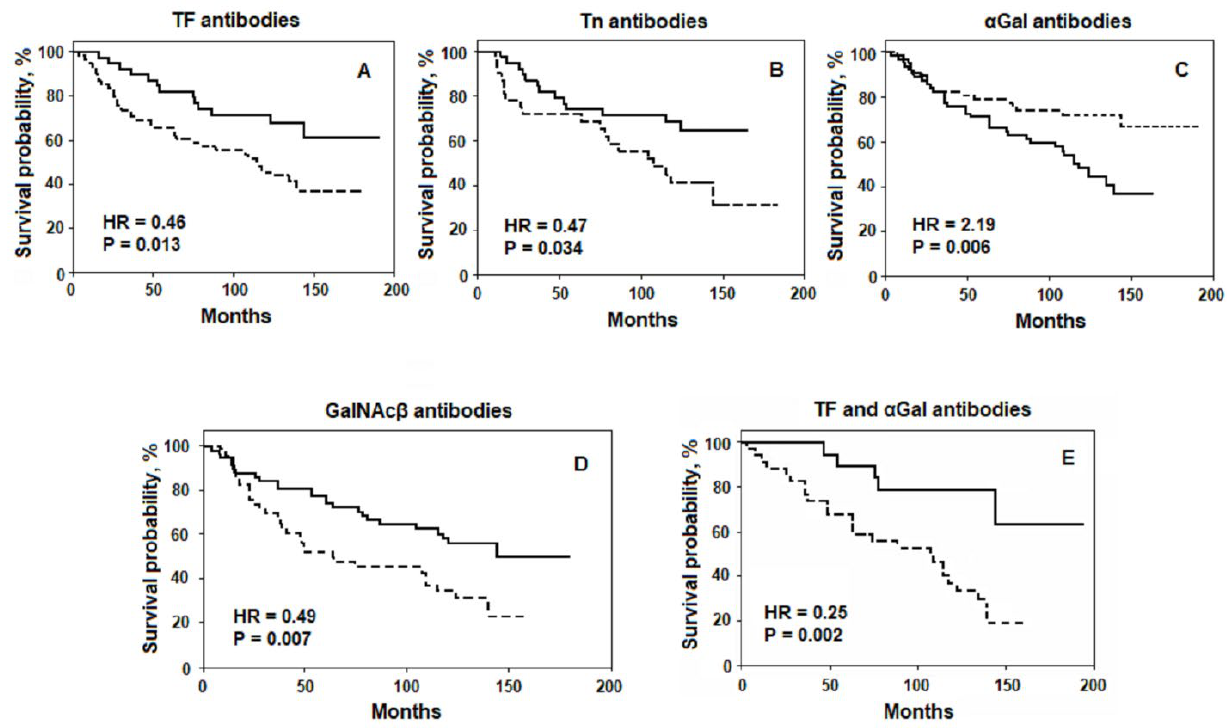
Figure 1. The relation of the preoperative AG Abs level to the survival rate of patients with gastrointestinal cancer. Solid line: level of serum AG Abs above or equal to the median; dashed line: the level below the median. ( A ), ( C ) all patients; ( B ) patients with well and moderately differentiated G1-2 tumours; ( D ) patients with T2-4 size of the primary tumours. (E) the probability of survival assessed by two parameters: patients with increased anti-TF and decreased anti- α Gal Abs level (solid line) vs. patients with decreased anti-TF and increased anti- α Gal Abs level (dashed line). HR: hazard ratio. Adapted from [20,21]. (Under Creative Commons Act License).